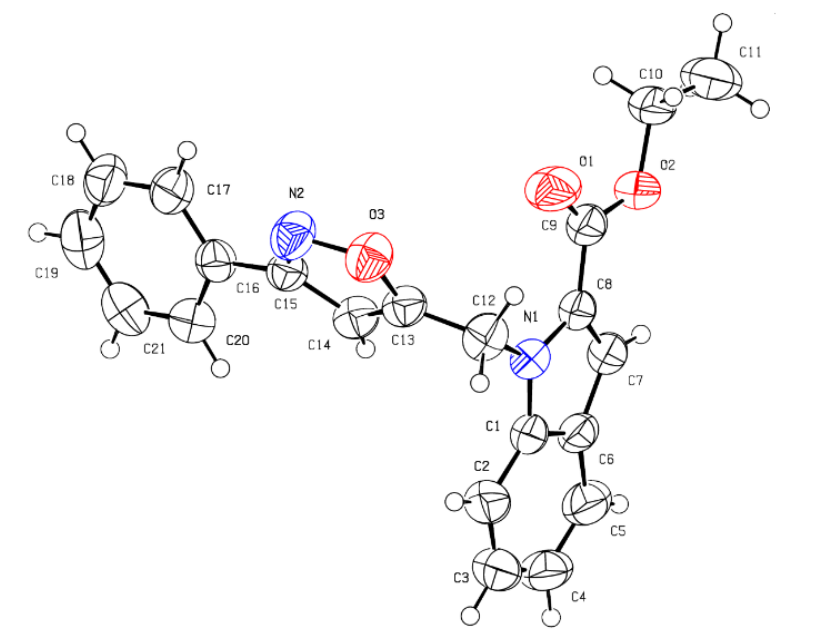
Figure 2 : Molecular structure and atom numbering scheme of 8 a. Thermal ellipsoids are drawn at 30% probability level.